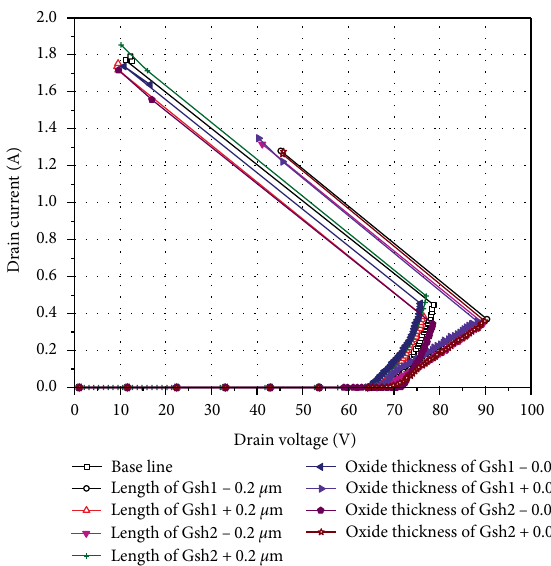
Figure 10: TLP test results of different gate shield